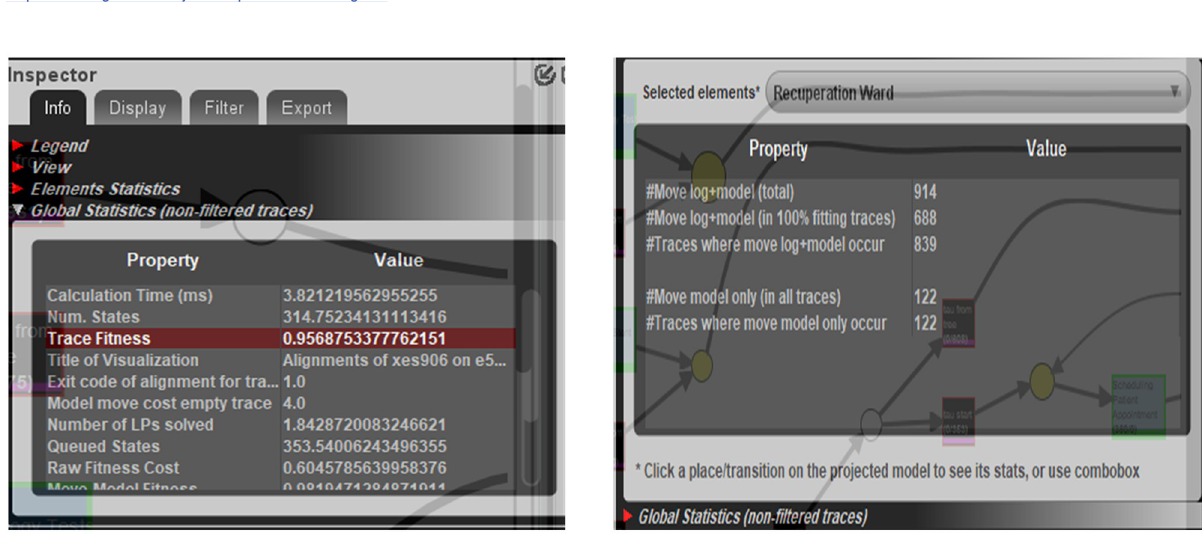
Fig 18. Replaying the Event Log and the Petri Net of the base Model “Standard model” for Conformance Analysis and Bottleneck analysis.